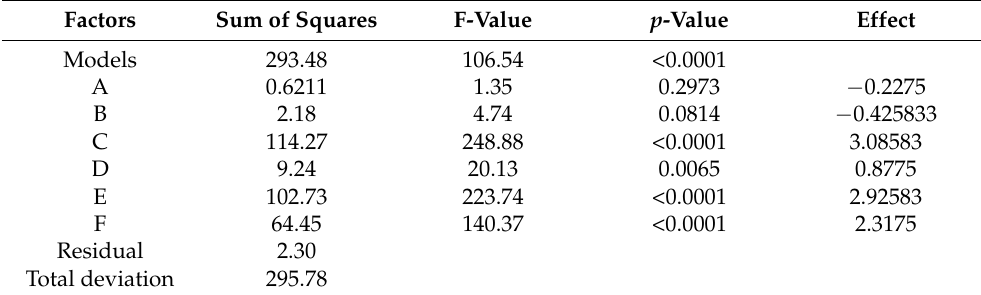
Table 3. Plackett-Burman test parameter significance analysis.